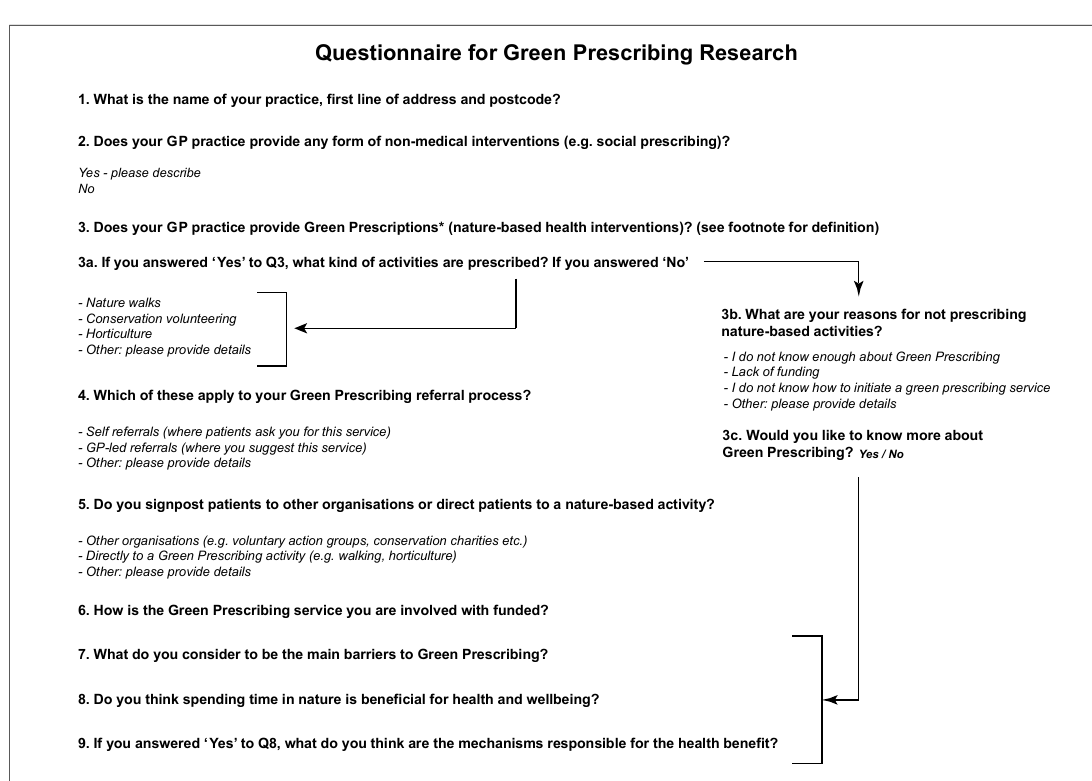
Figure A1. Green prescribing questionnaire for GPs.